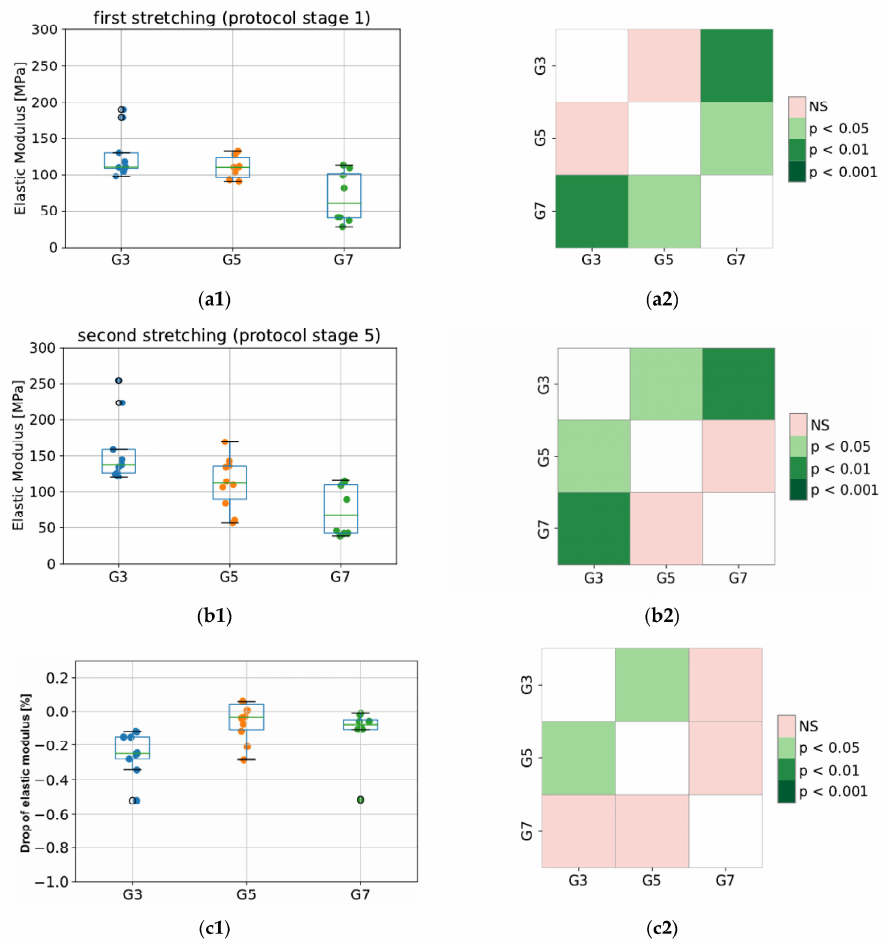
Figure 6. The values of elastic modulus for the first ( a1 , a2 ) and second ( b1 , b2 ) stretching, and the percentage decrease in modulus between second and first stretching ( c1 , c2 ). The colored maps indicate the probability of significant differences between tested groups. G3 refers to the group of porcine CDET samples, G5 refers to bovine SDFT samples, and G7 refers to deer SDFT